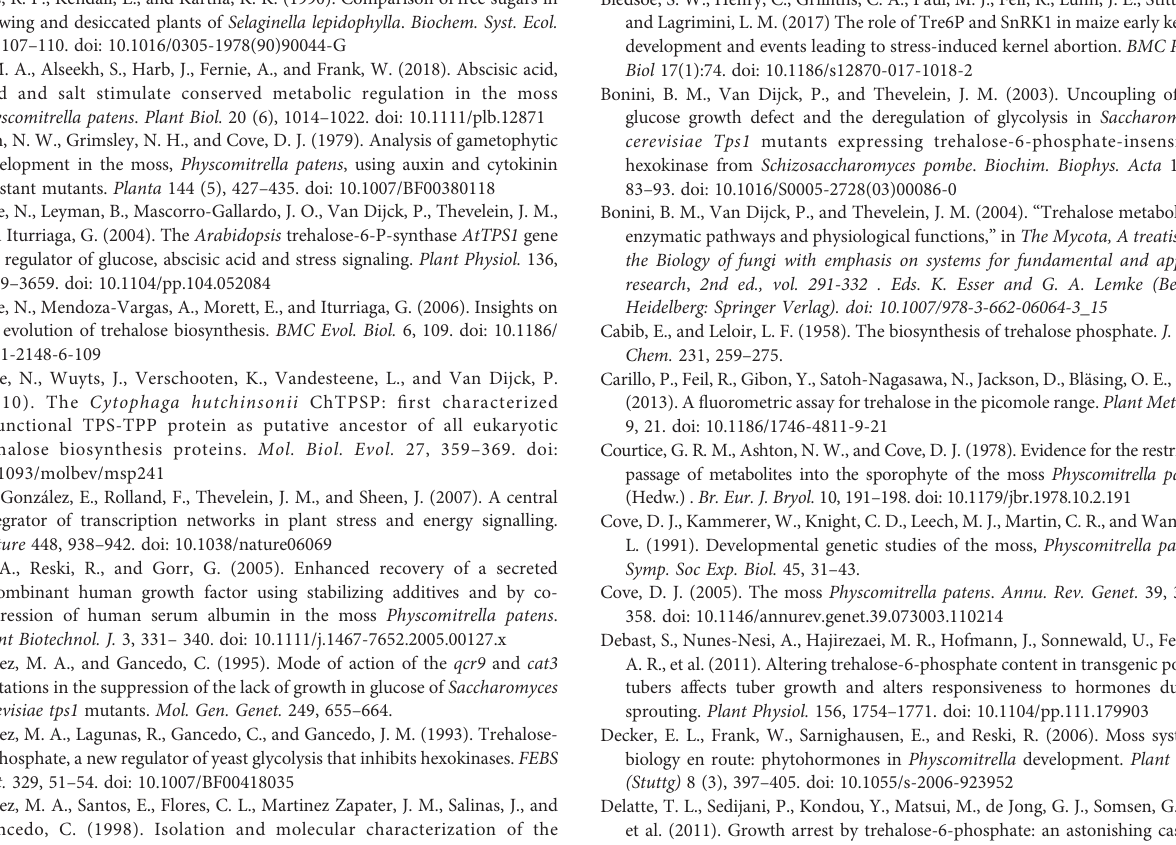
SUPPLEMENTARY FIGURE 2 | Caulonemal cells and chloronemal cells in protonema fi laments of wild-type (WT) and transgenic plants grown on BCDAT